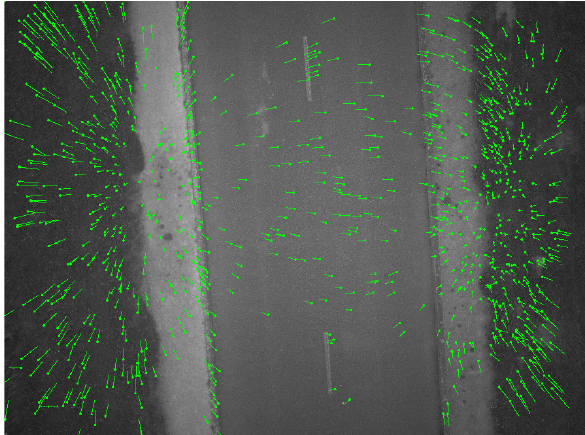
Figure 16. Residus obtained by the 3D rotation estimation be- tween the first image and the 10 th